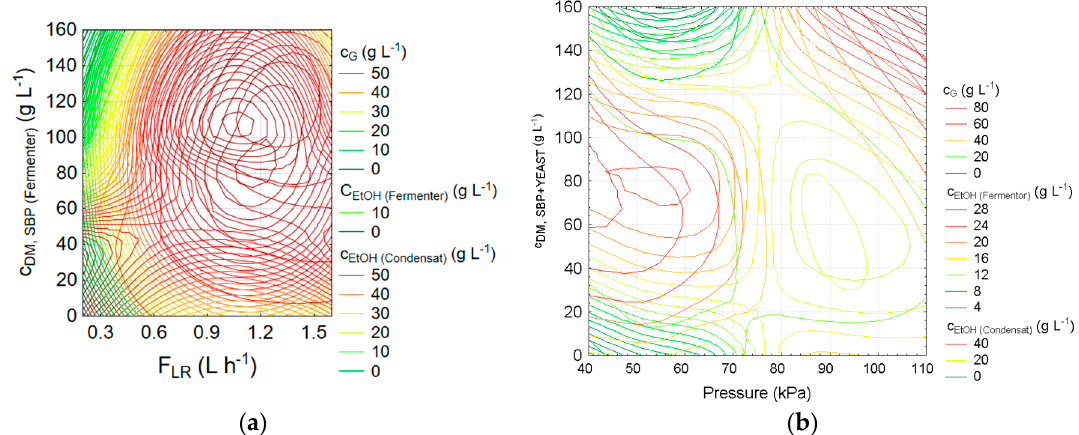
Figure 5. Contour plots of sugar- and ethanol concentrations during hydrolysis, fermentation and vacuum stripping as a function of ( a ) recycling ratio and solid concentration; ( b ) pressure and solid concentration.